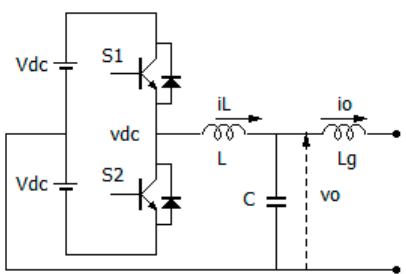
Figure 2. Single-phase half-bridge inverter circuit.